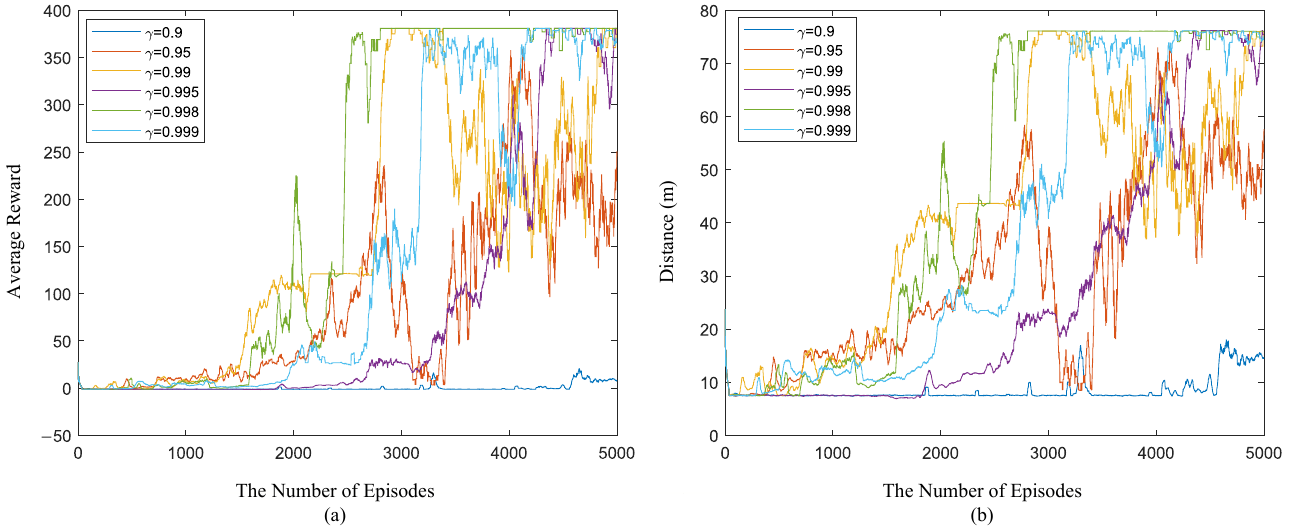
Figure 18. Comparison between different training parameters: ( a ) average reward of the last 30 episodes in the training process; ( b ) average maximum distance of the last 30 episodes.